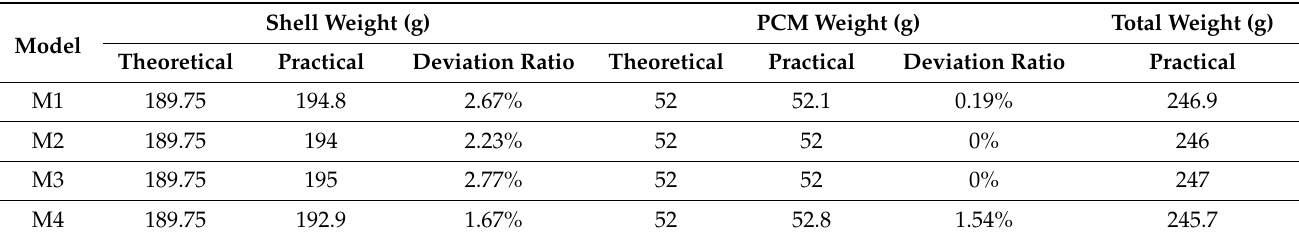
Figure 3. Weight of module ( a ) before PCM filling and ( b ) after PCM filling. Table 1. Weight deviation table between shell and PCM.